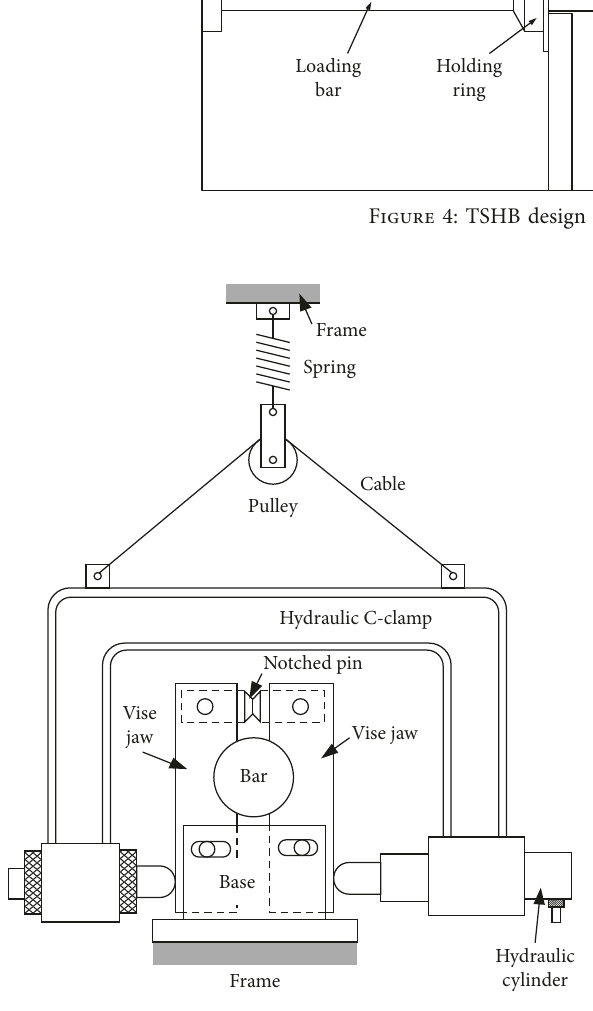
Figure 5: The clamp with a notch pin modified by Hartley et al. [48].